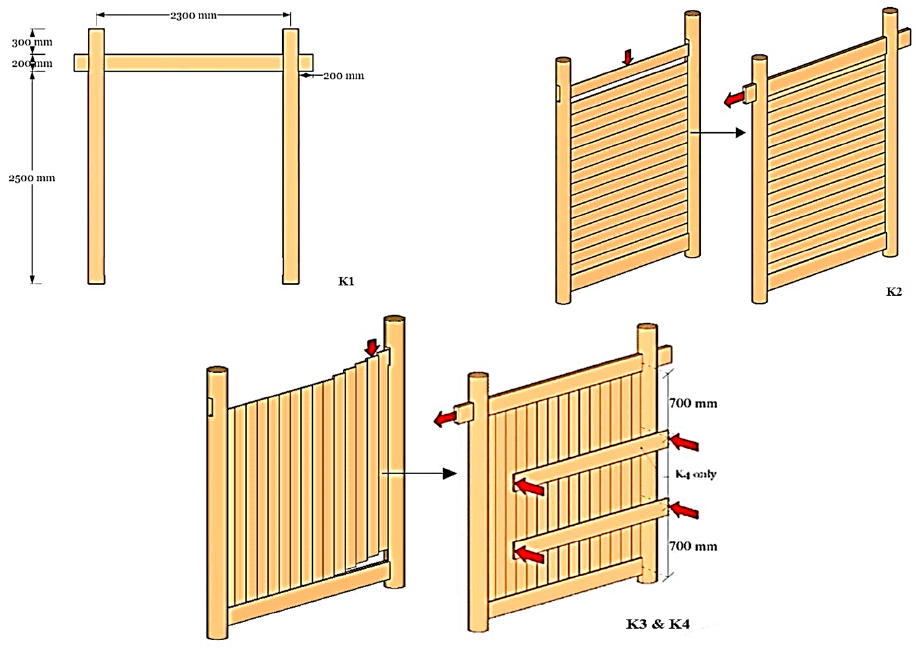
Figure 12. Specimens’ configuration in Tu et al. study